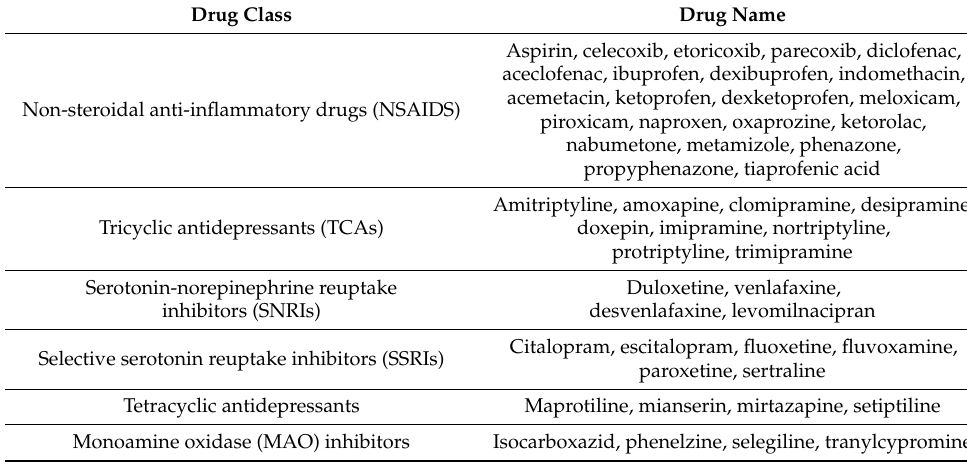
Table 1. The specific drugs included in the